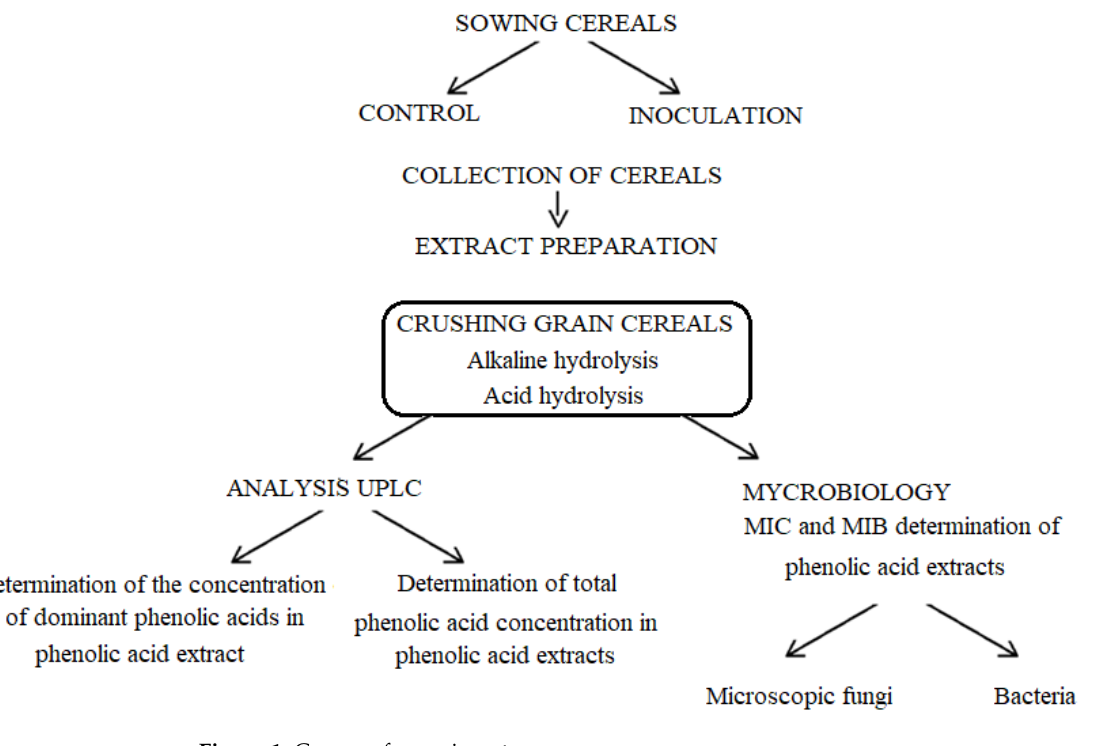
Table 2. Selected small-grained cereals grown at the D ł o ń Experimental Agricultural Station in the years 2017–2019.